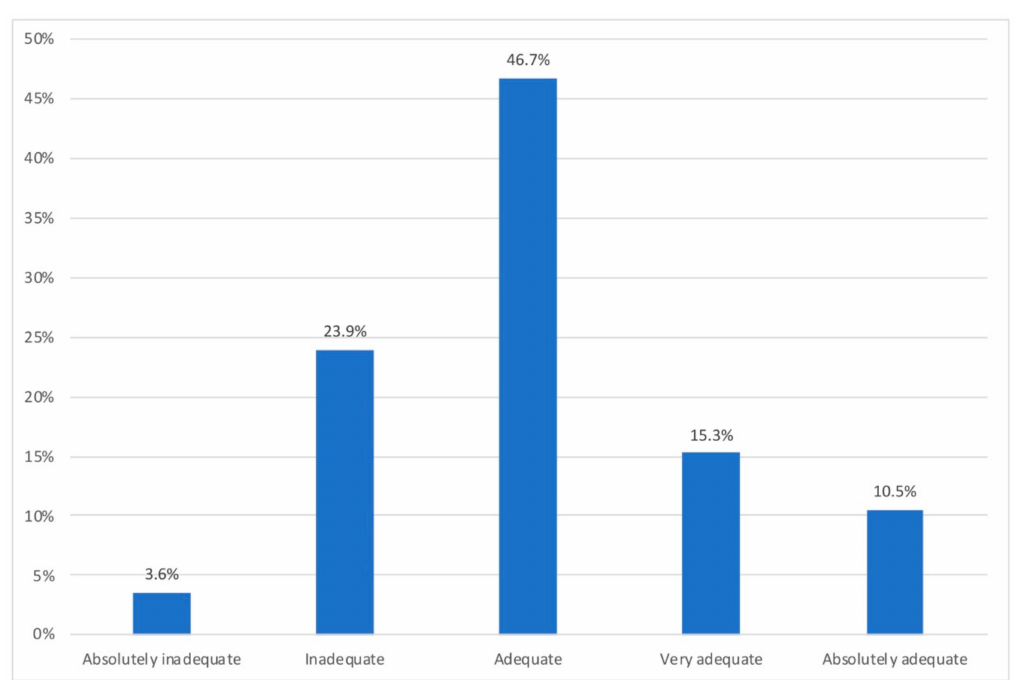
Figure 4. Adequacy of the telework